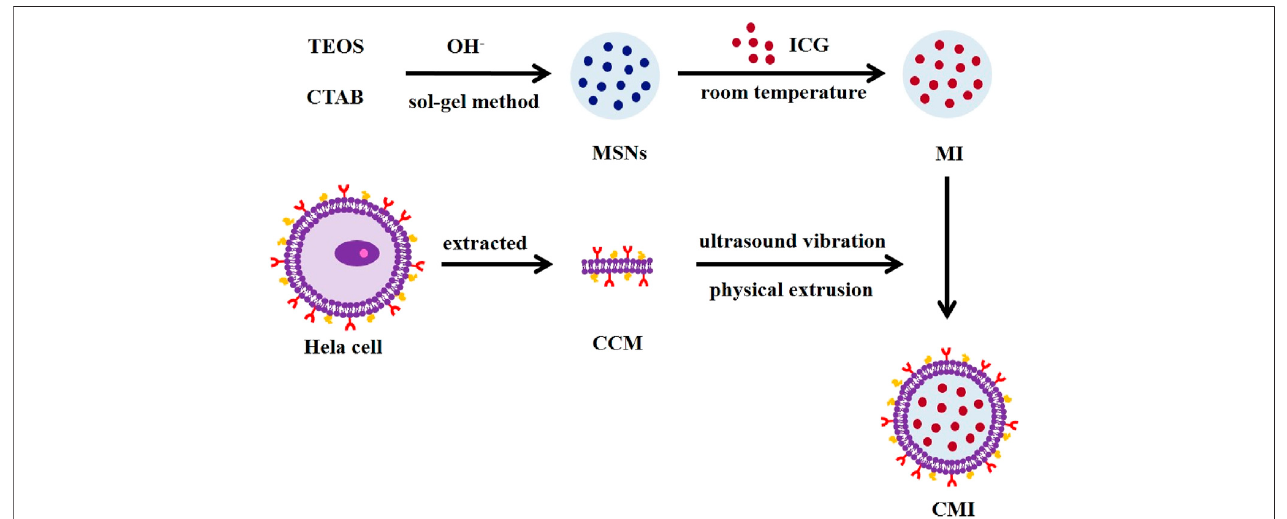
FIGURE 1 | Schematic illustration of